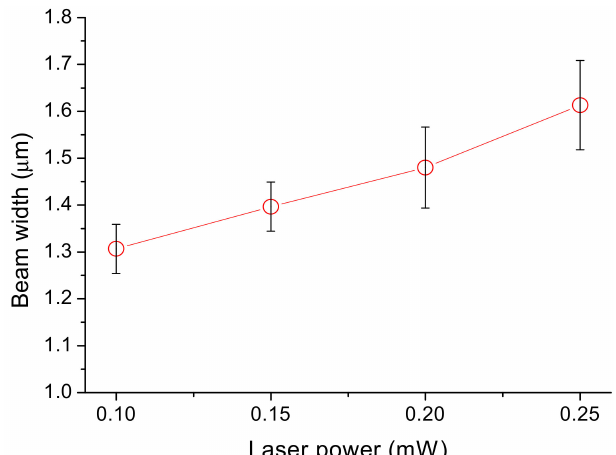
Figure 7. Effect of laser power on the cantilever bar width: The variation in the width of the cantilever bars with laser power under fixed inter-voxel x and y distances of 0.13 ì m and an inter-voxel z distance of 0.16 ì m. The circles represent data averaged from three specimens and the error bars indicate the standard deviation of data. As the average laser power increases from 0.1 to 0.25 mW, the width increases from 1.31 to 1.61 ì m.